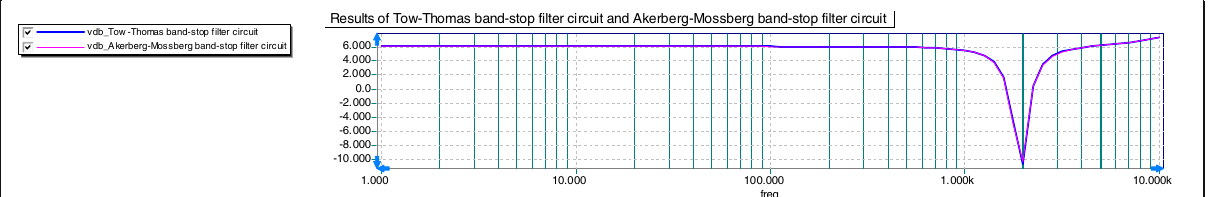
Fig. 14 The simulation results of TT band-stop filter circuit and Åkerberg-Mossberg band-stop filter